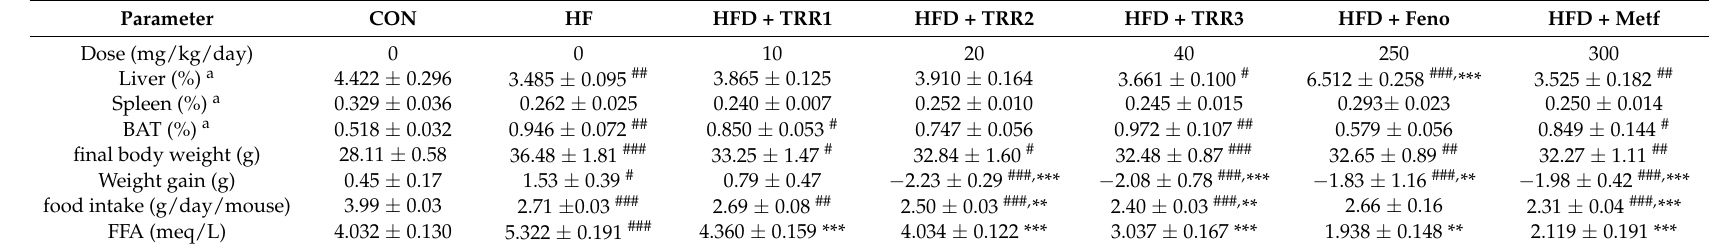
Table 1. Effects of TRR on relative tissue weight, food intake, and blood parameters in HFD-fed